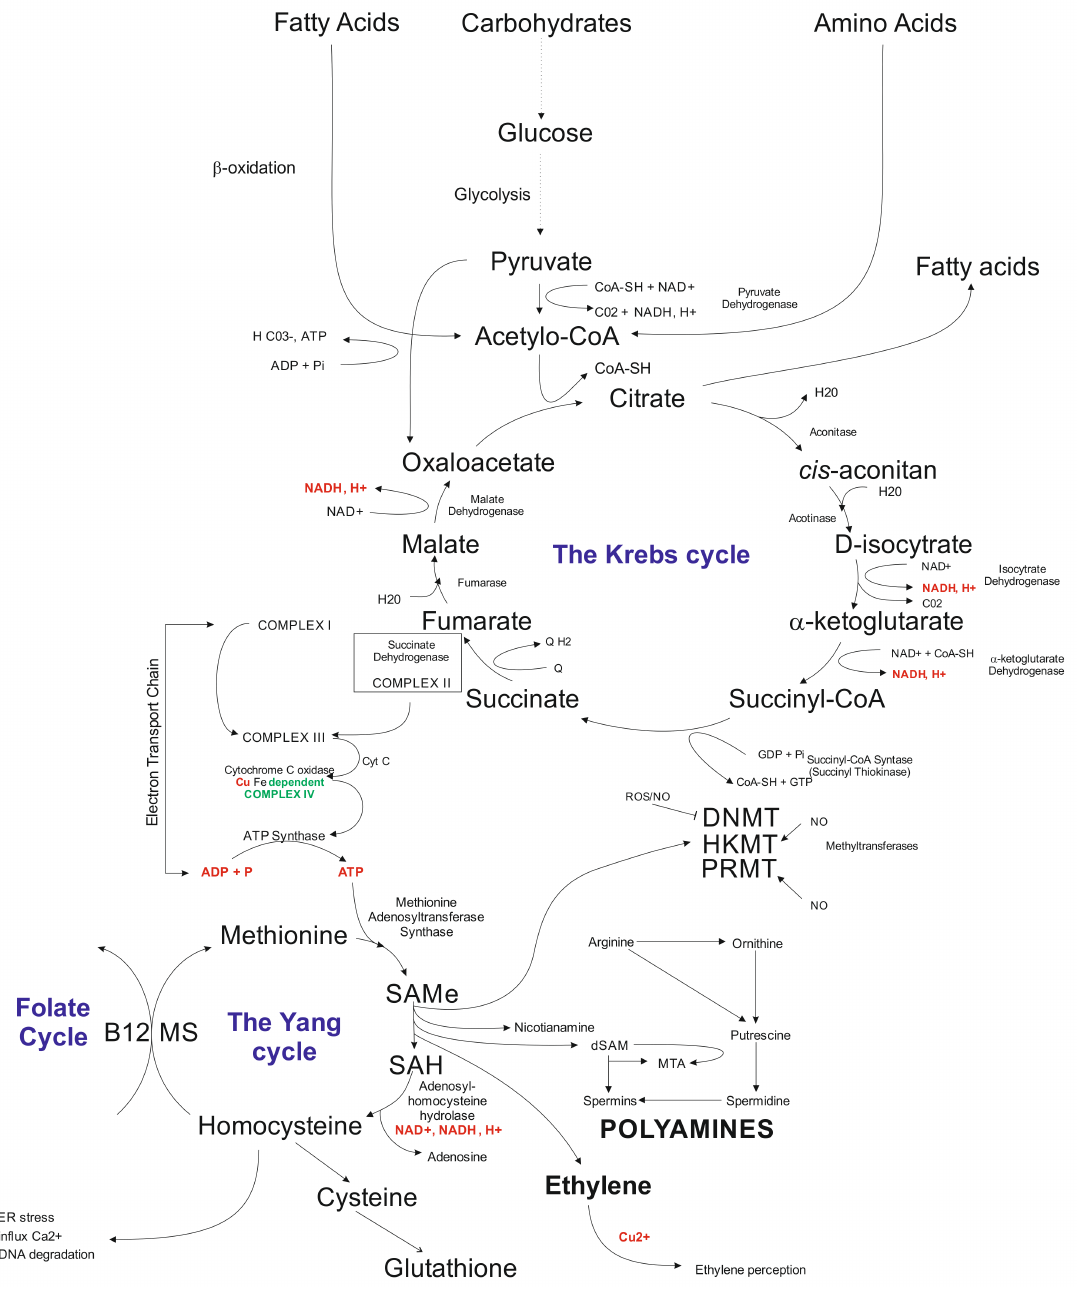
Figure 2. Schematic illustration of biochemical cycles that may participate in the induction of in vitro tissue culture variation. Briefly, under cold treatment and darkness and maltose presence, carbon starvation stress results in disfunction of glycolysis affecting the Krebs cycle. Disbalance in the Krebs cycle could be sensed at the electron transfer chain level via complex II and problems with ATP synthesis, which influence the Yang cycle. The latter is responsible for producing SAM involved in 80% of the cell compounds’ methylation processes, including genomic cytosines. The Yang cycle’s mall functioning may also influence glutathione production (antioxidant) used but the cell during oxidative stress. Oxidative stress may modify methylated cytosine inducing point mutations. Furthermore, byproducts of the Yang cycle may regulate transcriptome as the result of abiotic stresses. Abbreviations: B12 (vitamin B12); CoA (Coenzyme A (acyl-CoA); CoASH (coenzyme A not attached to acyl group); DNMT (DNA methyltransferase); dSAM (decarboxylated SAM); ER stress (endoplasmic reticulum stress); HKMT (histone lysine methyltransferase); PRMT; MS (methionine synthesis); MTA (5 (cid:48) -methyl thioadenosine); NAD (nicotinamide adenine dinucleotide); NADH (1,4-dihydro-nicotinamide adenine dinucleotide); PRMT (protein arginine N-methyltransferase); ROS (radical oxygen species); SAMe (S-adenosyl-L-methionine); SAH